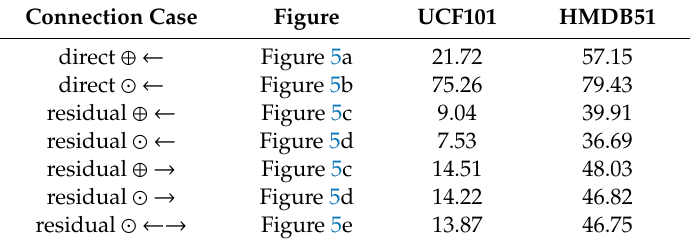
Table 2. Classification errors (%) on UCF101 and HMDB51 of the two-stream encoder with di ff erent cross-stream connections. We use ⊕ to denote an addition operation and use (cid:12) to denote an element-wise multiplication operation. The directions from the motion to the appearance stream and from the appearance to the motion stream are denoted as ← and → , respectively, while we use ←→ to denote the bidirectional connection. Connection Case Figure UCF101